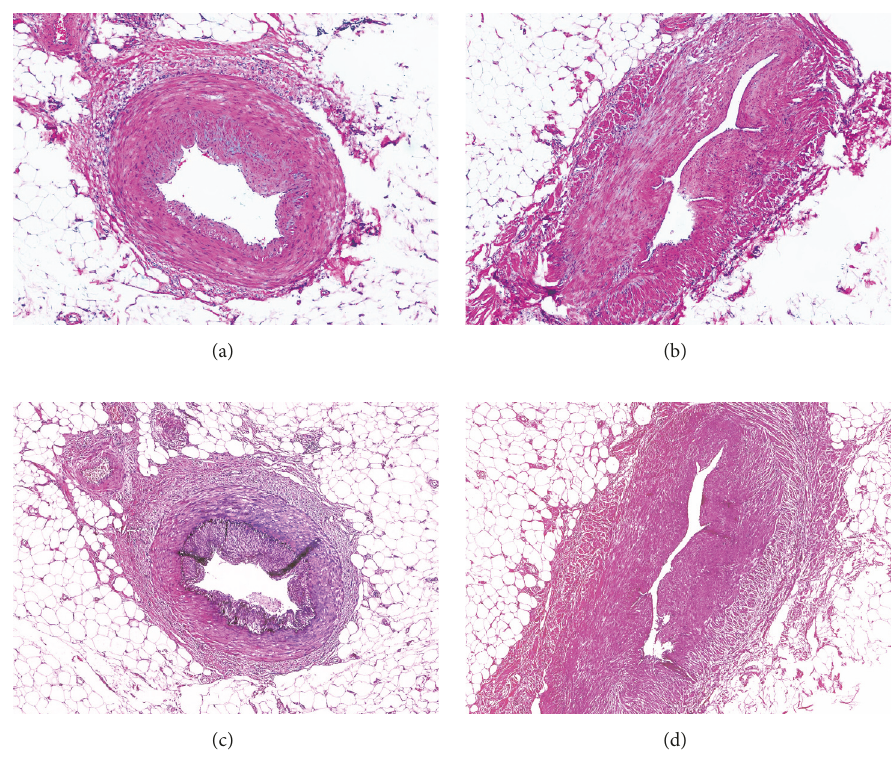
Figure 3: Paired H&E (a, b) and elastin (c, d) stained high-magnification images of mesenteric vessels in the pericolonic soft tissue. Elastic laminae, visible in the artery (a, c), are absent from the vein (b, d), which shows myointimal